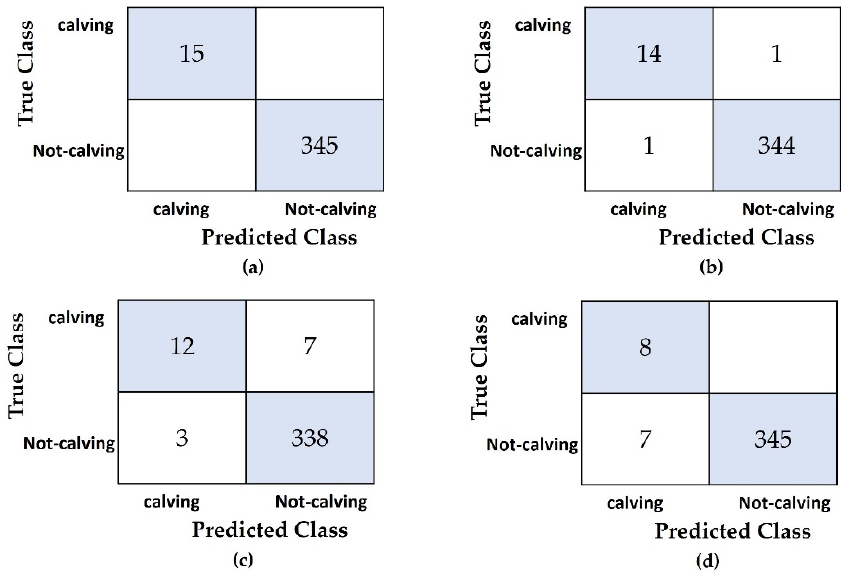
Figure 8. Confusion matrices of predicting calving events by using ( a ) Proposed Method, ( b ) NB, ( c ) KNN, and ( d ) ( c ) KNN, and ( d ) SVM.